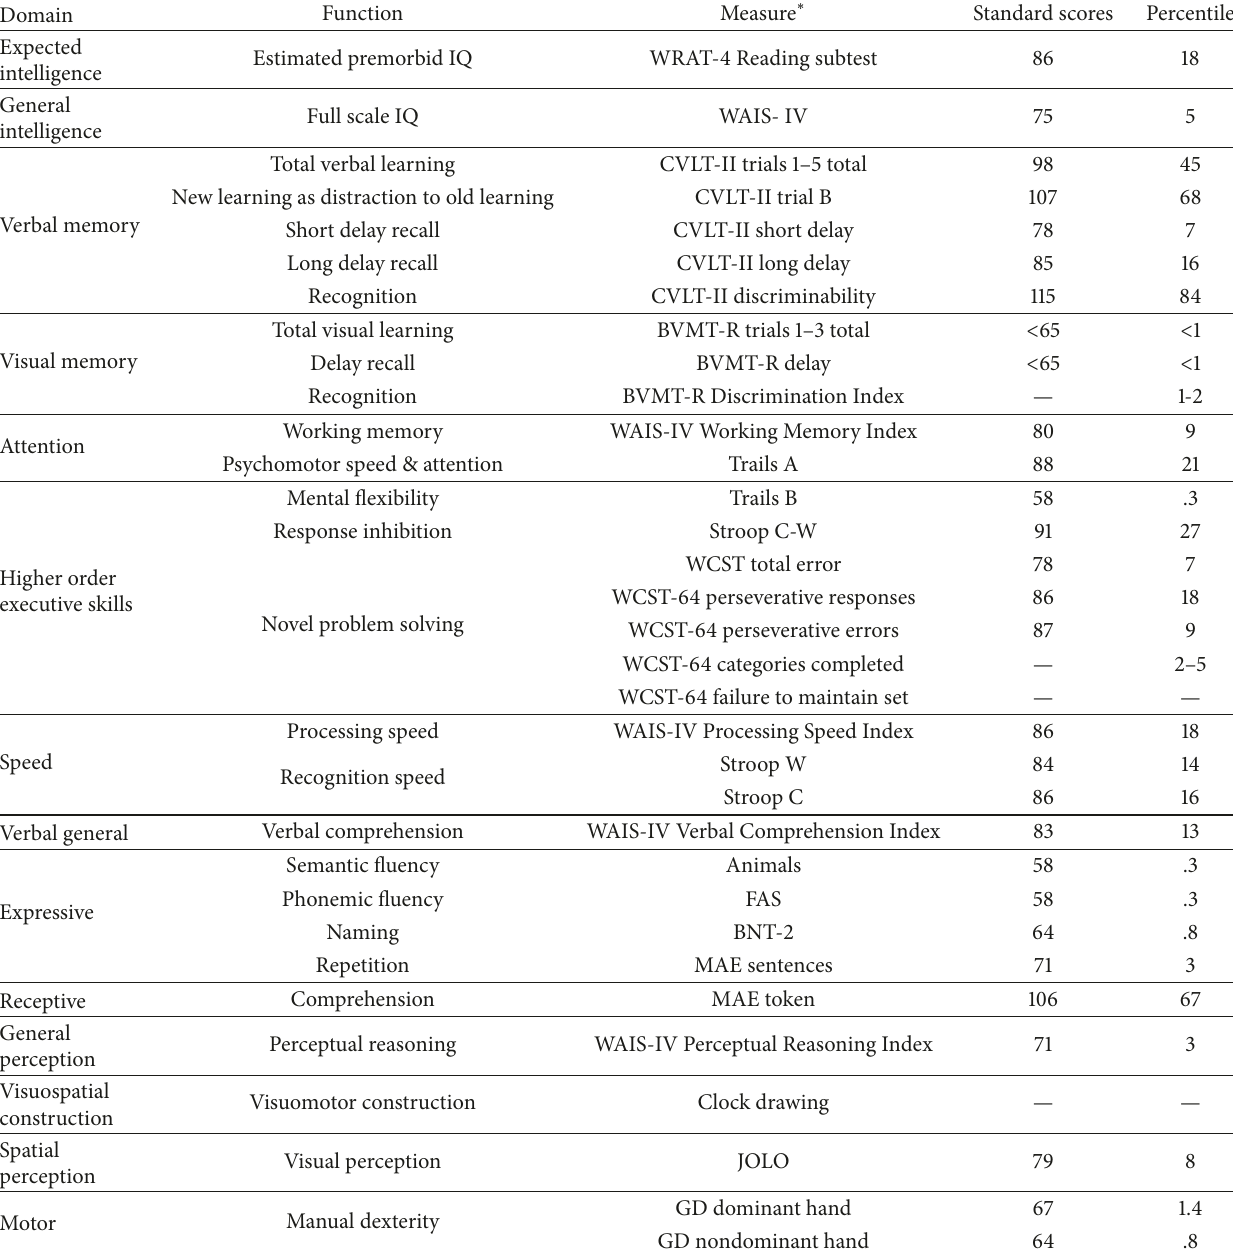
Table 1: Neuropsychological test